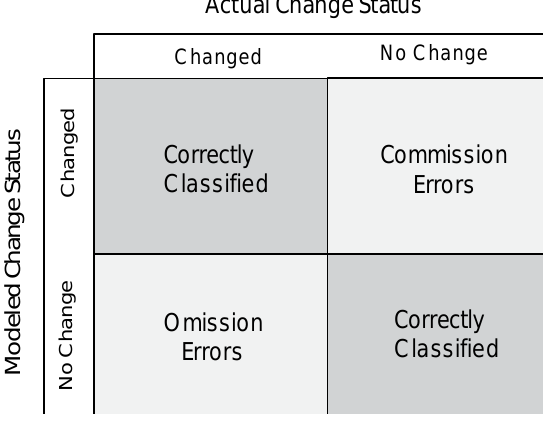
Figure 1. Confusion matrix for mapping land cover